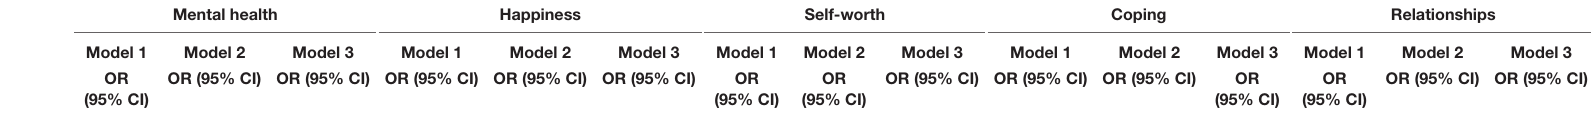
TABLE 3 | Multiple logistic regression analysis of the association of ARHL severity and psychological dimension of